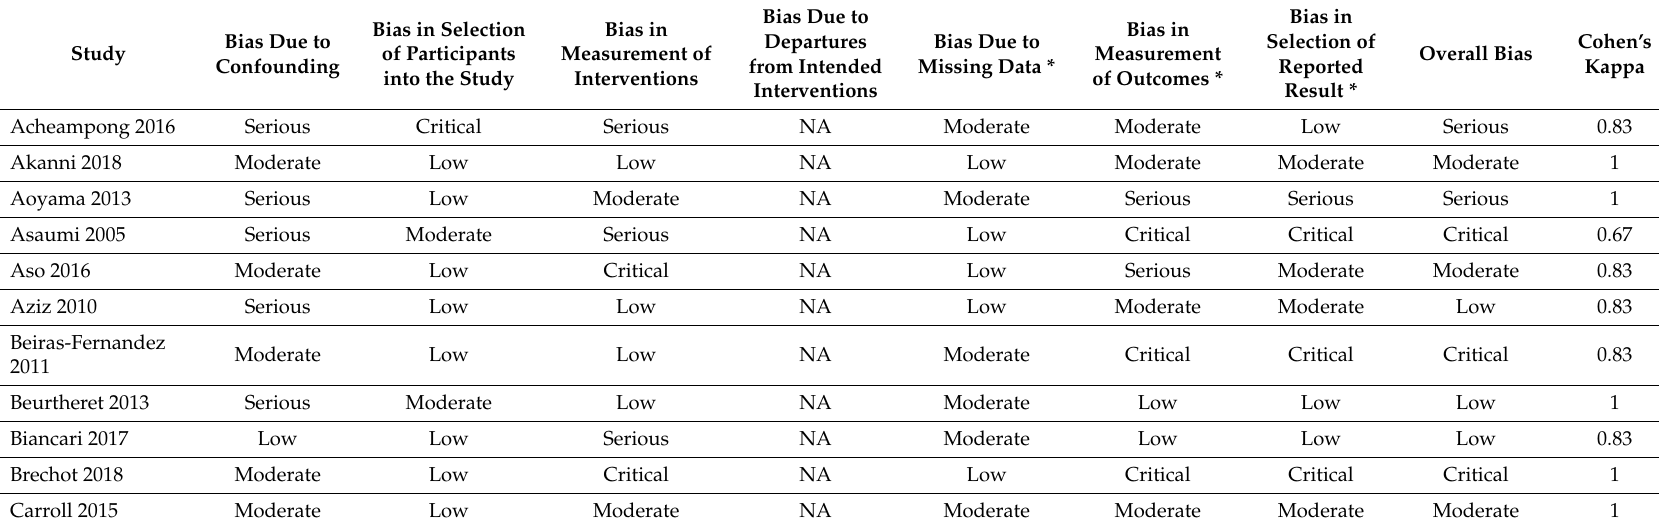
Table A4. ROBINS-I tool bias